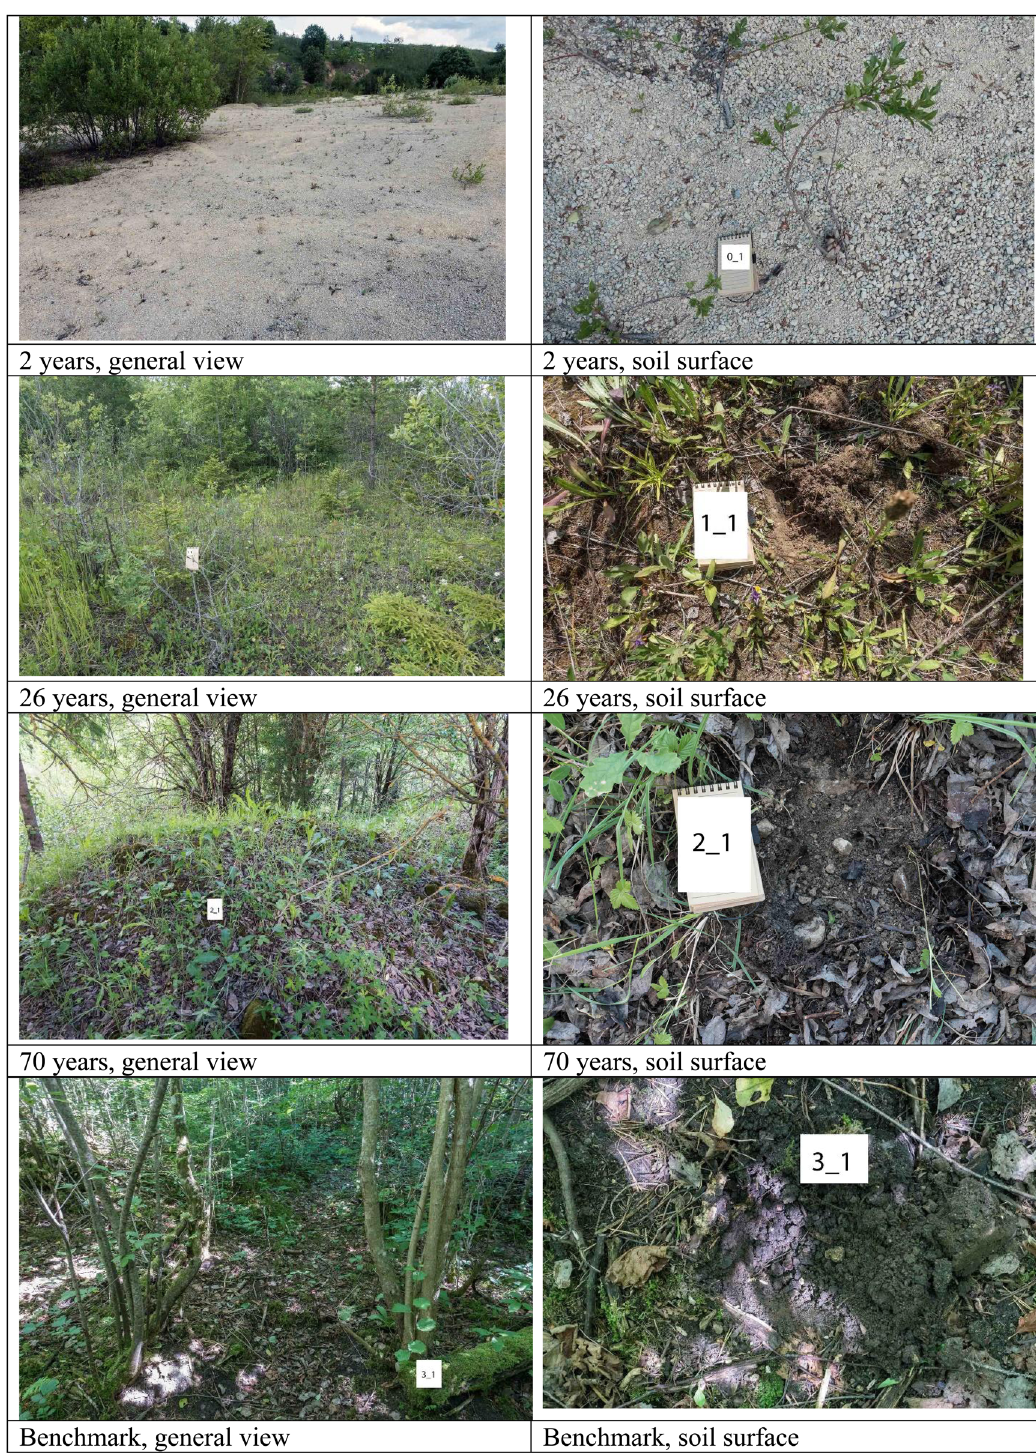
Figure 2: Soils of di ff erent stages of